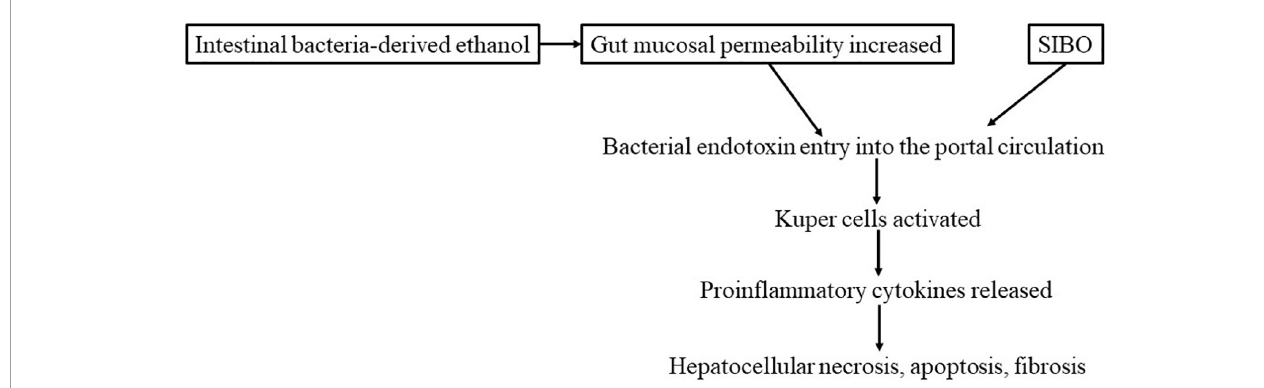
FIGURE3 Development and exacerbation of NASH by intestinal bacteria